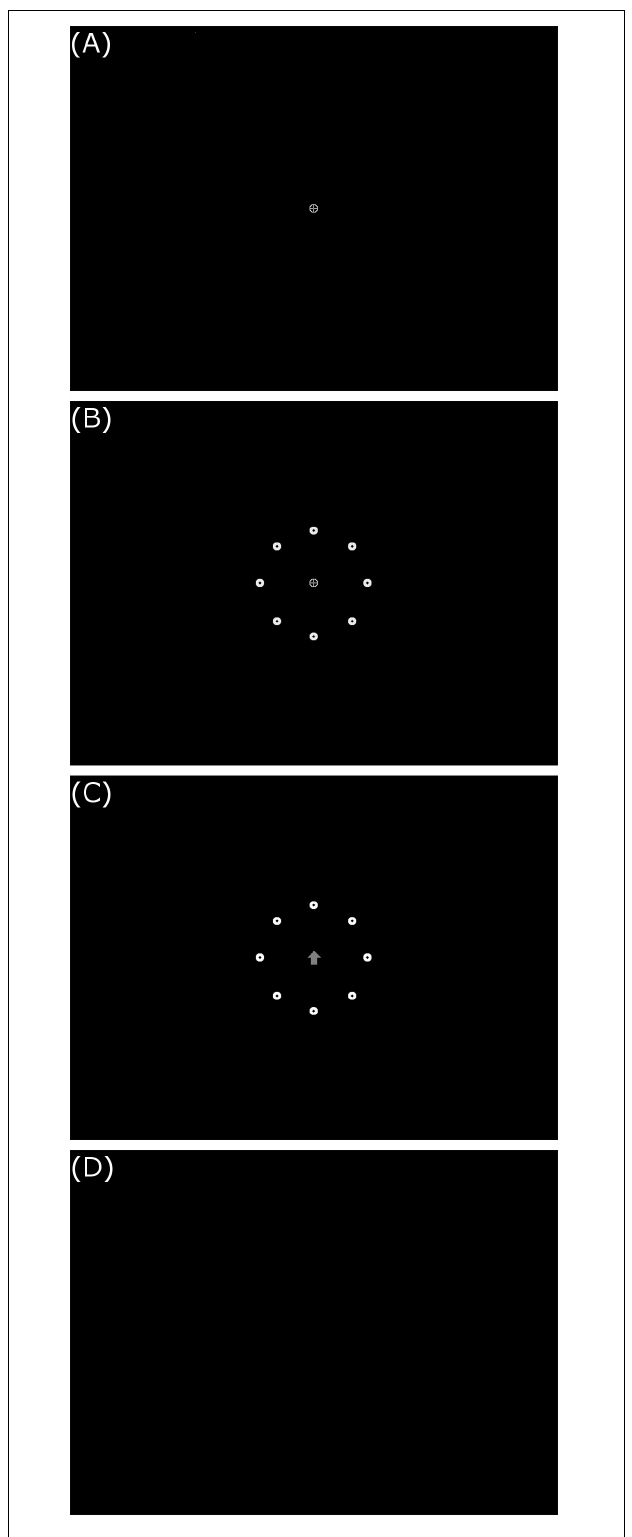
FIGURE 1 | Example training/testing trial display sequence. (A) Central fixation target, (B) 20 ◦ target circle, (C) northern direction indication arrow, and (D) blank reset screen. All images presented in 800 × 600 resolution on